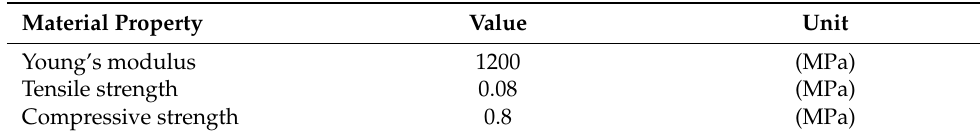
Table 3. Flexural behaviour of masonry walls.